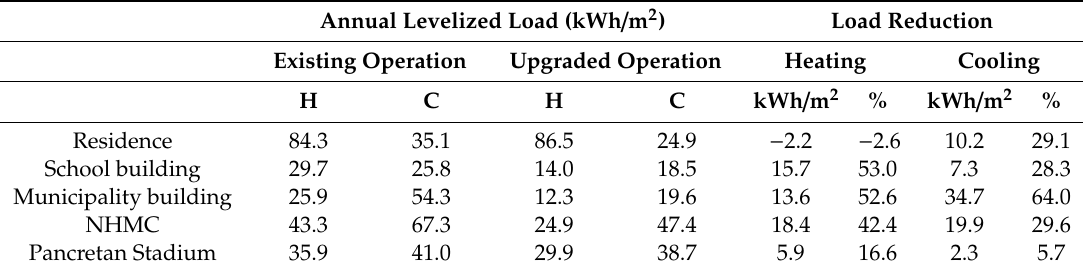
Table 7. Heating and cooling loads reduction with the integration of the proposed passive